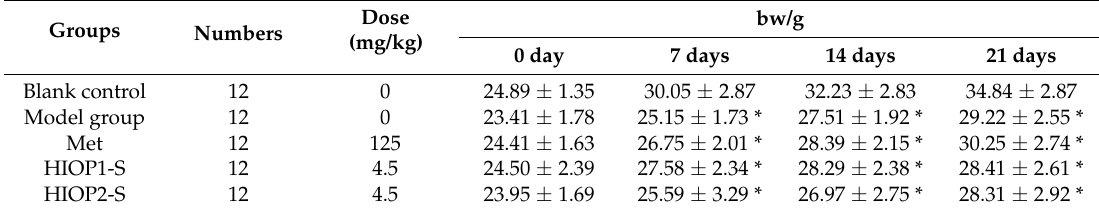
Table 4. Effects of HIOP1-S and HIOP2-S on the body weights of STZ-induced diabetic